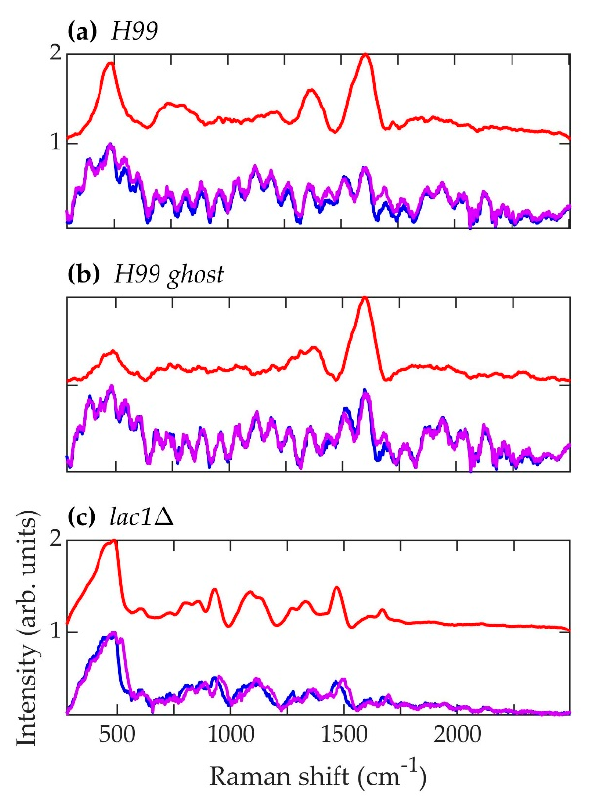
Figure 7. Spectra corresponding to C. neoformans strains ( a ) H99, ( b ) H99 ghost, and ( c ) lac1 Δ . Blue (~784.1 nm laser excitation) and purple (~785.8 nm laser excitation) curves are the average normalized background-subtracted raw spectra, while the red curves are average retrieved pure Raman spectra.